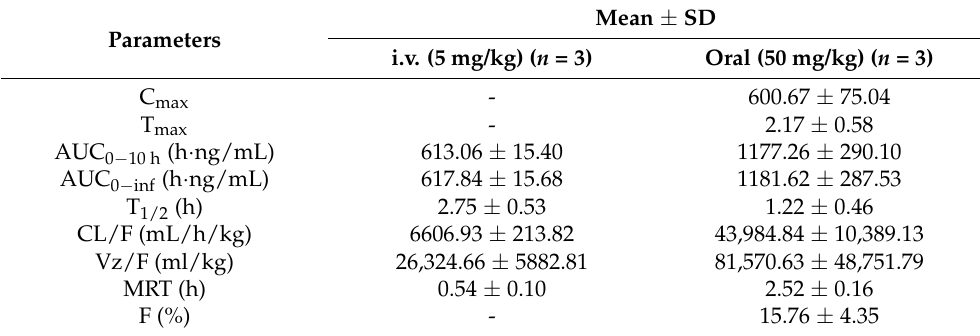
Table 5. Pharmacokinetic parameters of MPI8 after IV and oral administration of MPI8 sulfonate to rats (data derived from NCA).